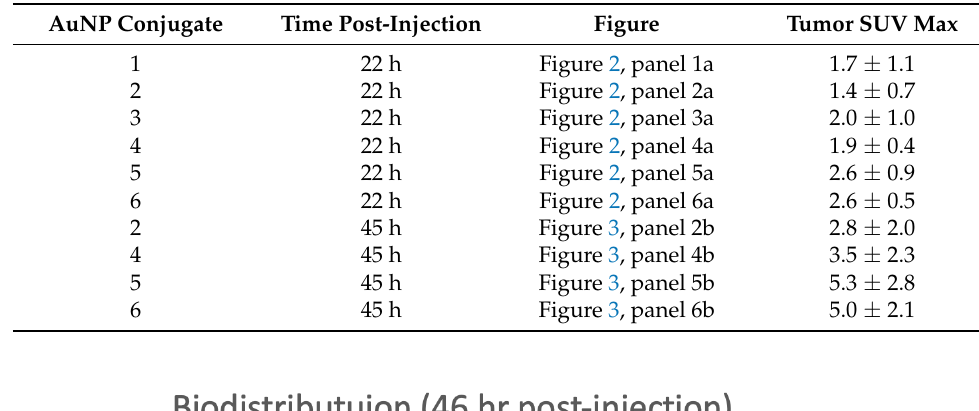
Table 4. SUV Max of gold nanoparticle conjugates in tumor.